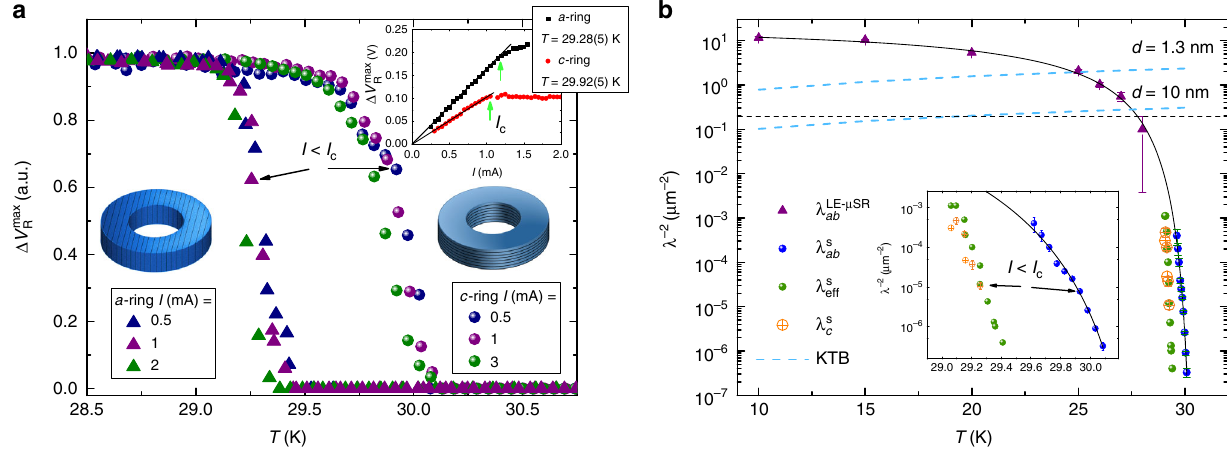
Fig. 3 LSCO x = 0.125 stiffness. a Comparison between a - and c -rings, which are demonstrated in the fi gure, as measured by the Stiffnessometer. The signal is normalized by the maximum measured ring voltage. Different transition temperatures are observed for the two kind of rings with 0.7 K difference between them. The transition does not depend on the applied current in the inner coil up to 1 mA. The highest temperatures for which the current in the coil I is clearly smaller than the critical current I c are marked. Inset: Critical current measurement I c of c -ring at T = 29.92(5)K and a -ring at T = 29.28(5) K. b Semi-log plot of λ (cid:2) 2 ab as measured by LE- μ SR (purple solid triangles) and Stiffnessometer (blue solid spheres). Error bars are the results of the fi tting procedures. Black dashed line represents the sensitivity limit of LE- μ SR. Black solid line is a fi t to a phenomenological function described in the text. Dashed cyan lines represent the KTB line for layer widths d = 1.3 nm and d = 10 nm. Green solid spheres represent the penetration depth of an a -ring from the Stiffnessometer, analyzed as if the ring is isotropic with λ eff which is some combination of λ ab and λ c . Orange open symbols show λ c obtained at the temperature range where their ratio is manageable numerically for analysis. The inset is a zoom-in on temperatures close to the transitions. The highest temperatures for which clearly I < I c and the extraction of λ is valid are